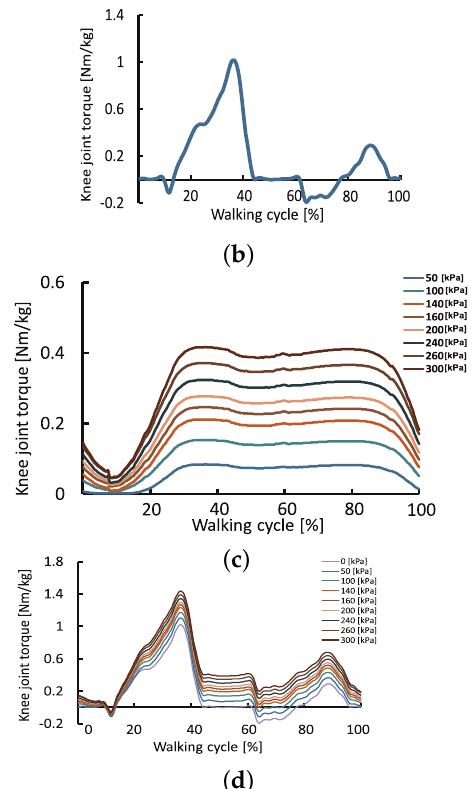
Figure 8. Knee joint torques generated by the force feedback suit: ( a ) kinematic model of the suit; ( b ) simulation results of the knee joint torque τ W , ( c ) knee joint torque τ M , and ( d ) knee joint torque τ